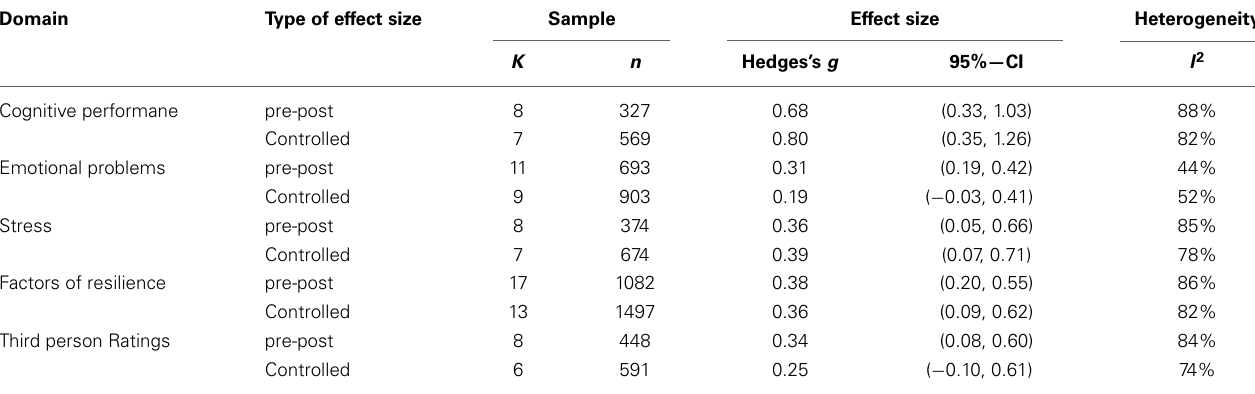
Table 5 | Domain specific effect sizes and statistics for within group and controlled effects sizes